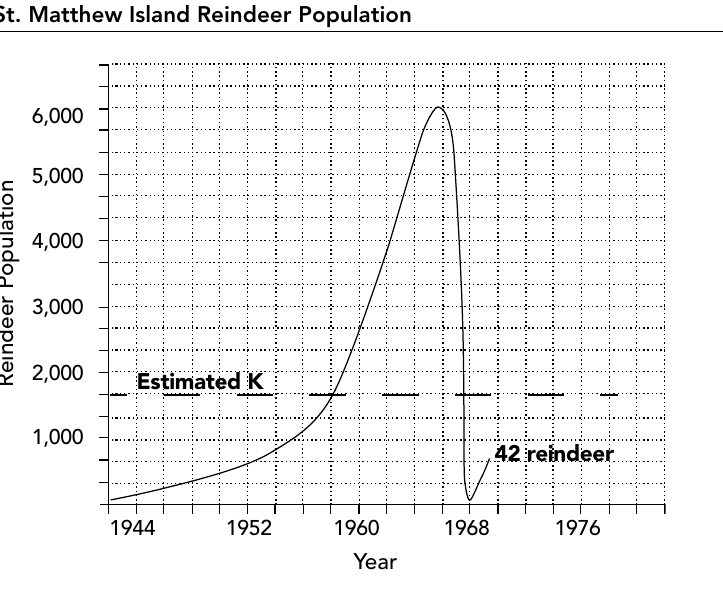
Fig 2. The Reindeer Population of St. Matthew Island. Image created by Saudiberg. https://en.wikipedia.org/wiki/St._Matthew_Island#/media/File:St._Matthew_Island_